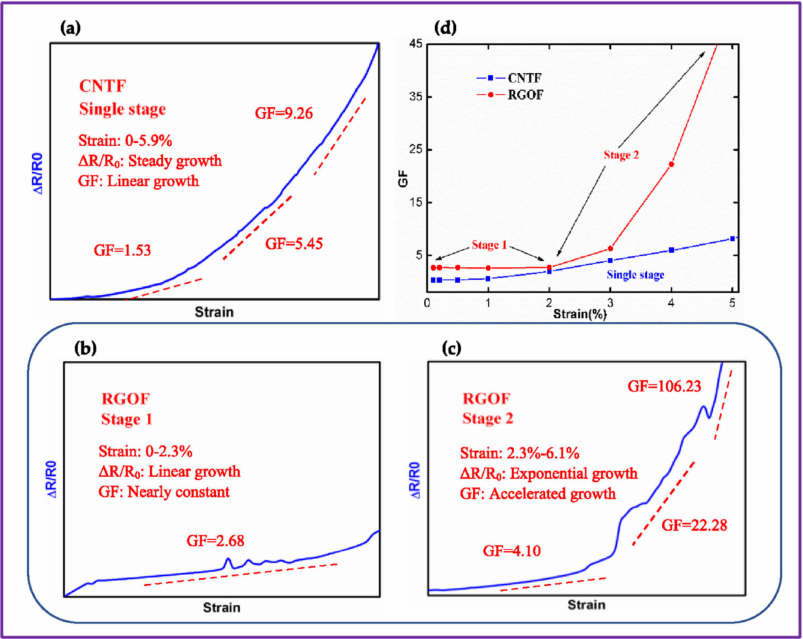
Figure 10. Detailed piezoresistive response of ( a ) CNTF and ( b , c ) RGOF in tension-to-failure test, reflecting their single (CNTF) and double (RGOF) stages of sensing behavior; ( d ) Comparison of the growth of GF between CNTF and RGOF as a function of mechanical strain [104].